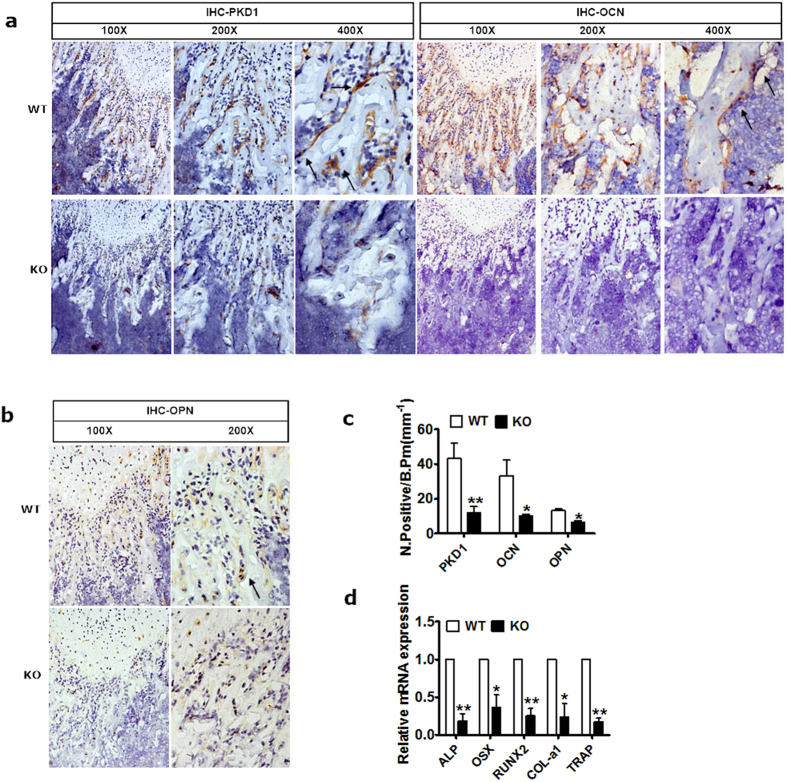
The expression of osteoblastic differentiation markers were inhibited by PKD1 deficiency.(a,b) IHC staining of PKD1 and osteoblastic markers OCN and OPN in femur from 4-week KO and control mouse. Positive osteoblasts were showed by black arrows. (c) Number of PKD1 positive, osteopontin positive (N.OPN+) and osteocalcin positive (N.OCN+) osteoblasts on the bone surface were measured as positive cells per millimeter of perimeter in sections (B.Pm). Measurements were presented as mean ± SD. *p < 0.05 versus respective control. The data in each group were analyzed using unpaired, two-tailed Student’s t-test. (d) Relative mRNA expression levels of osteoblast differentiation markers (ALP, OSX, Runx2, and col-α1) and osteoclast marker (TRAP) in long bone from wild-type and PKD1-KO female mice. The level of each marker gene expression was normalized to the level of the housekeeping gene. n > 3, WT and KO. *p < 0.05.